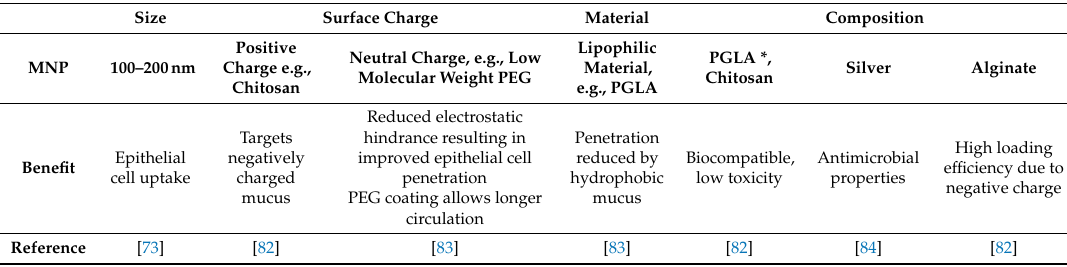
Table 5. Characteristics of magnetic nanoparticles (MNPs) for